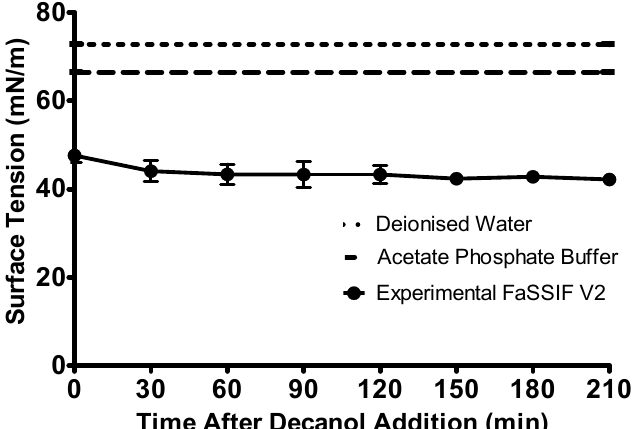
Figure 3. Change in the surface tension of the biorelevant media over the duration of the intestinal sector of the biphasic dissolution experiment. Surface tension of the FaSSIF V2 is represented by the circles, the surface tension of the acetate phosphate buffer is represented by the dashed line, the surface tension of deionised water is represented by the dotted line. Each data point represents the mean ± SD ( n = 3).